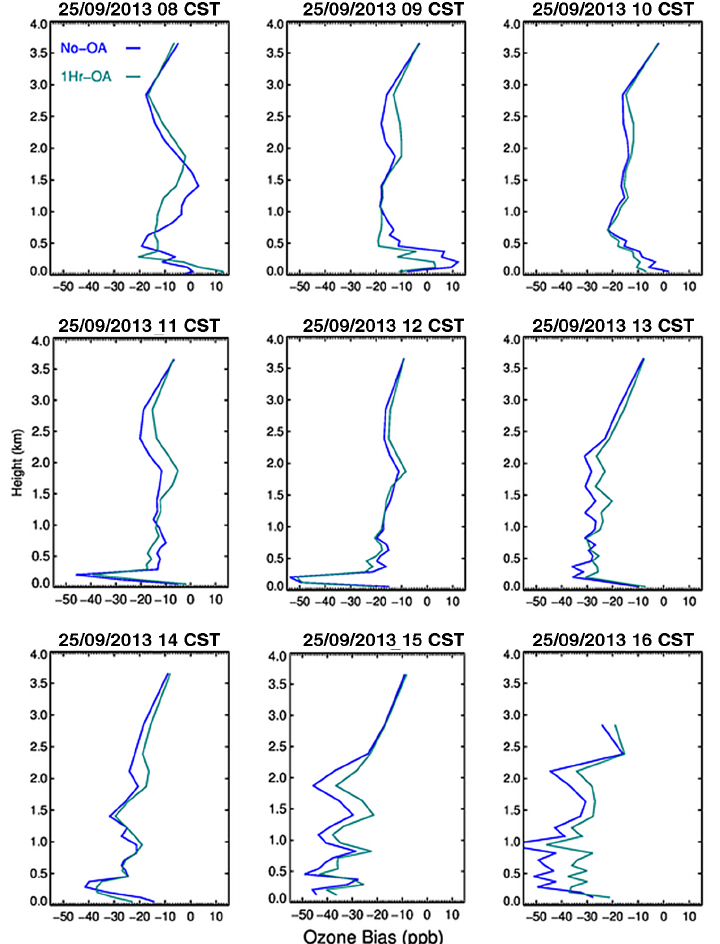
Figure 14. Model vertical ozone biases from 08:00 to 16:00CST on 25 September 2013 for two cases of No-OA and 1Hr-OA. There are nine plots, each for 1h, with date and hour as